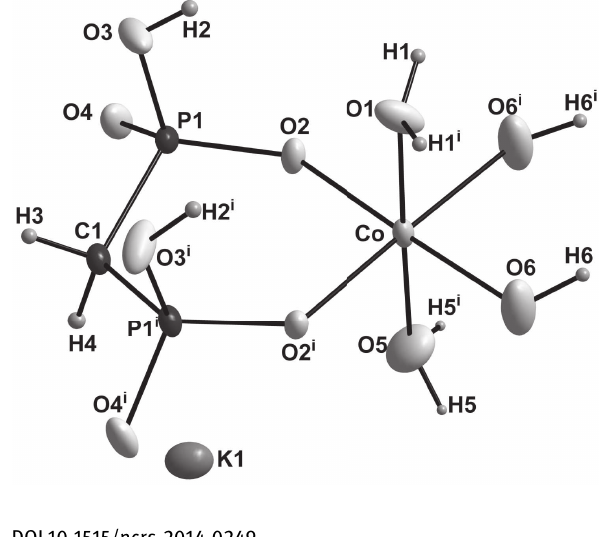
Table 1: Data collection and handling.